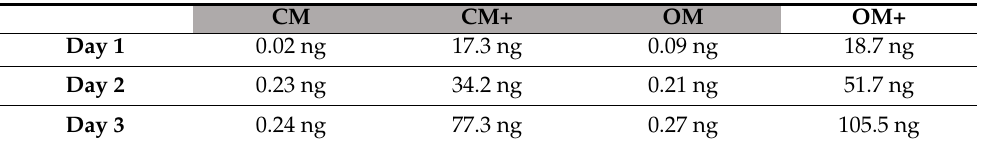
Table 1. The amount of BMP-7 protein in the supernatants of DPSC-BMP-7 cell line cultured in different media ( n = 3).